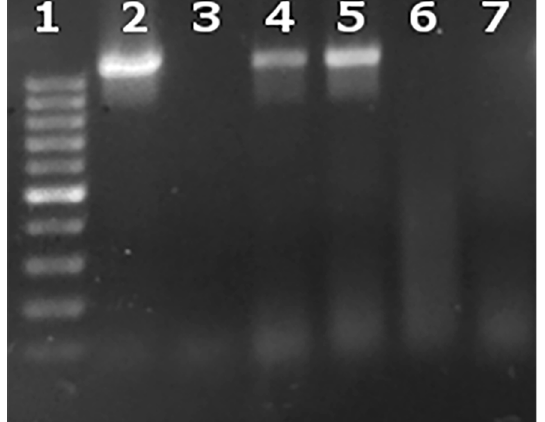
Figure 4. Intracellular and extracellular brucellae from one representative experiment at an MOI = 5000. Lane 1: 100–1000 base pair ladder; Lane 2: culture supernatant from macrophages before